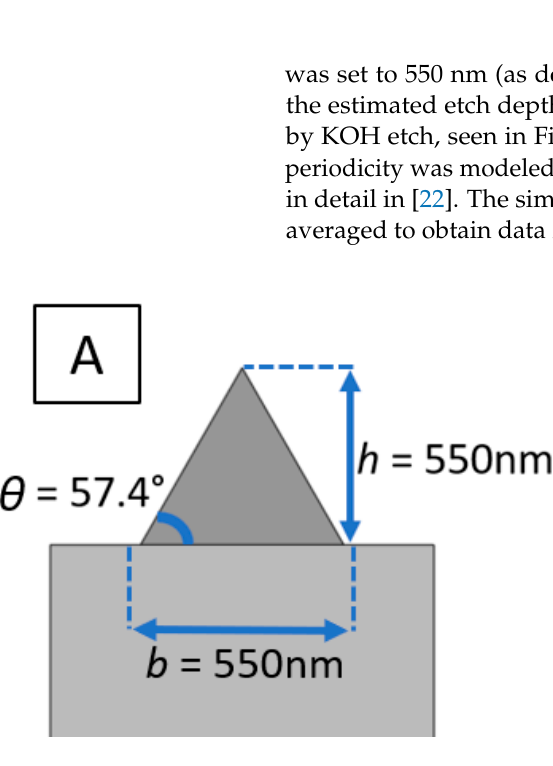
Figure 4 . ( A ) Schematic of the modified pyramid shape expected from the KOH etch with a base width, b = 550 nm, a height, h = 550 nm, and an etch angle, θ = 57.4°. ( B ) Schematic of the hemispher- ical ellipsoid with a periodicity of 800 nm used to simulate the estimated shape of the fabricated nanostructures where diameter, d = 350 nm, and height, h = 400 nm.